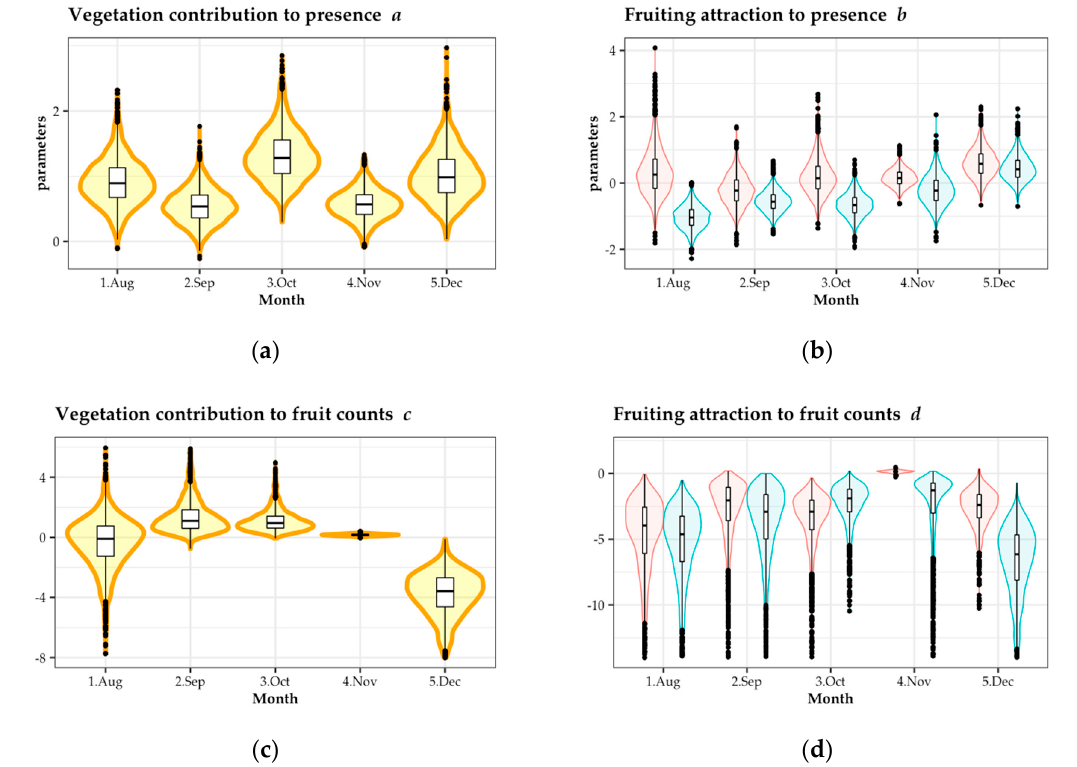
Figure 5. Bayesian analysis of the number of dispersed fruits in each seed trap from August to December of 2018. ( a ) Vegetation contribution to seed presence; ( b ) fruiting attraction to seed presence; ( c ) vegetation contribution to fruit counts; and ( d ) fruiting attraction to fruit counts. Red and blue in ( c ) and ( d ) denote parameters of fruit existence and fruit absence, respectively.